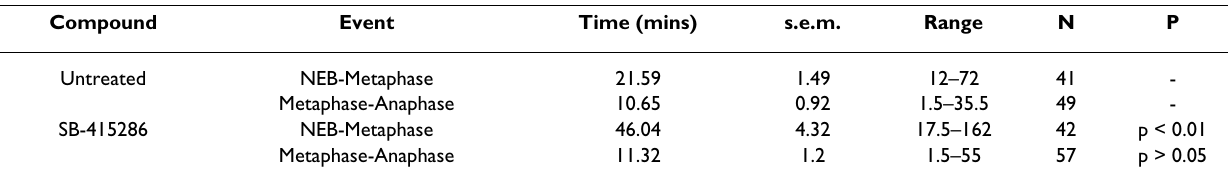
Table 2: Effect of SB-415286 inhibitors on mitotic timing